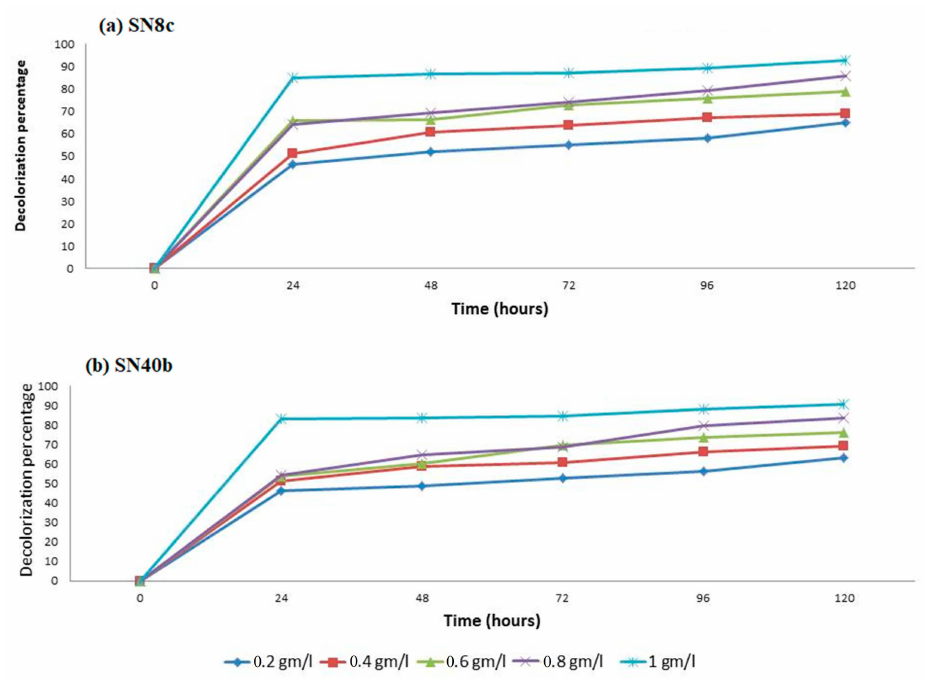
Figure 4. The effect of different glucose concentrations on the decolorization of RBB dye.